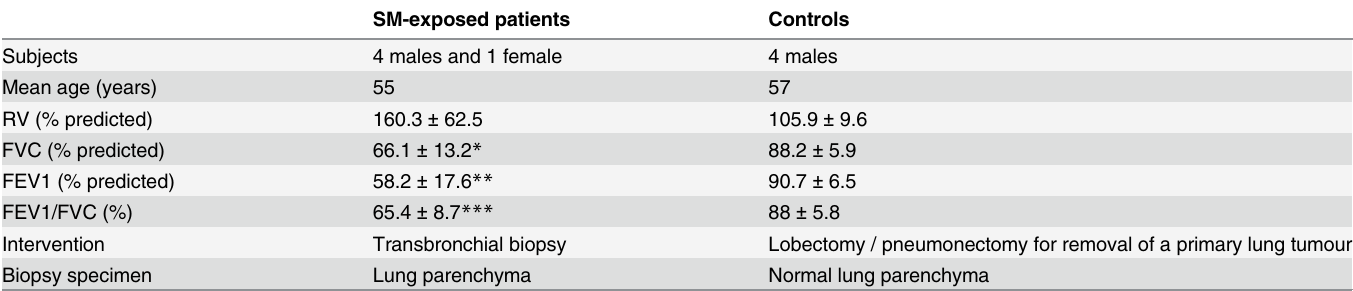
Table 1. Characteristics of the subjects and biopsy specimens.